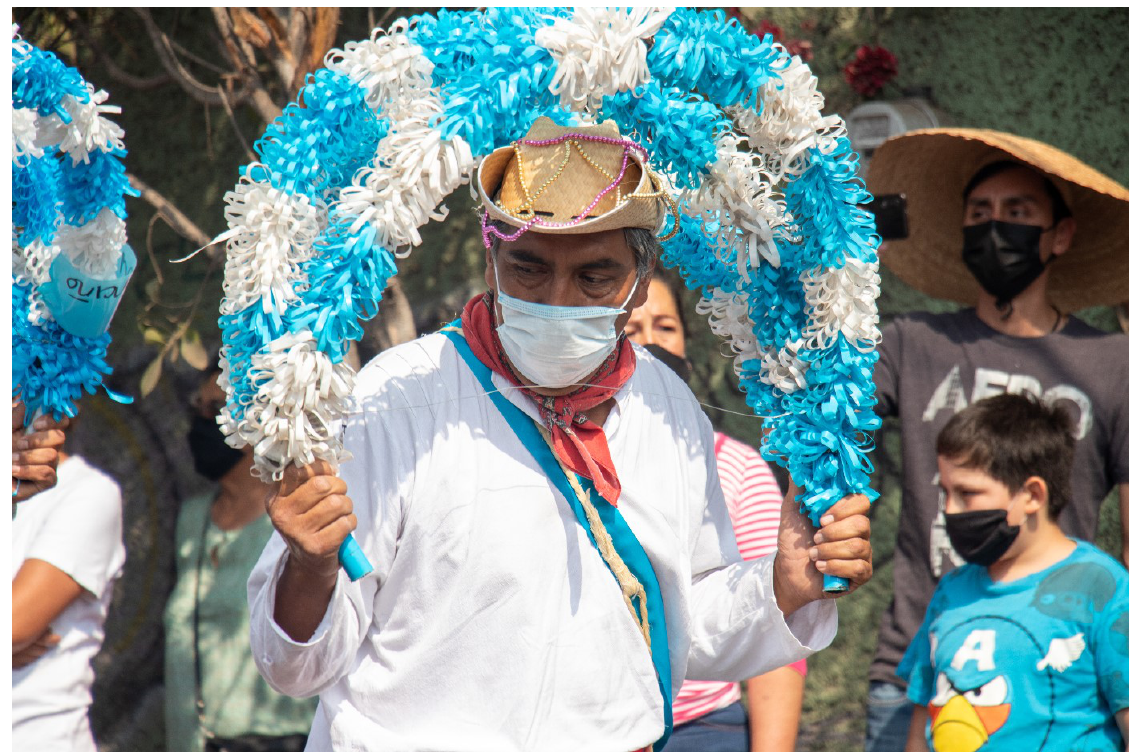
Figure 8 Principal dancer, Serranos dance in the procession of the feast honoring Our Lord of Graces, 2021. Tepexpan, Acolman, State of Mexico. Copyright: Isaac Trenado